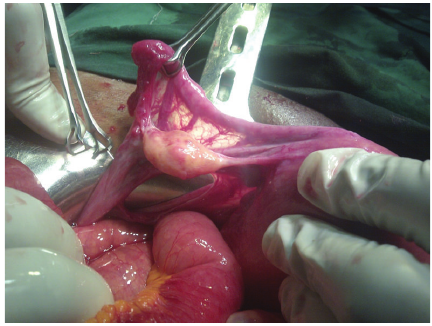
Figure 2: Congenital defect through the broad ligament.